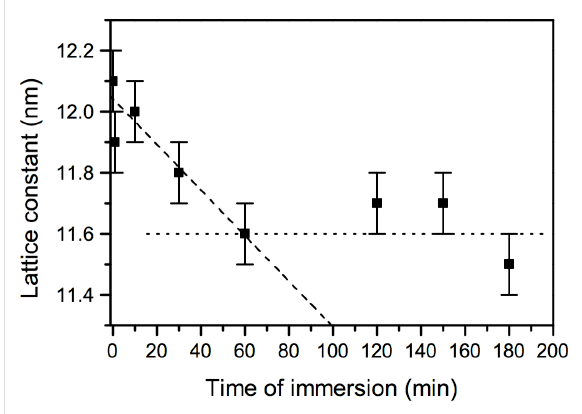
Figure 4: The change in lattice constant extracted from the radial power spectral density of SEM images taken from monolayers immersed for different durations. Dashed and dotted lines indicate trends for different